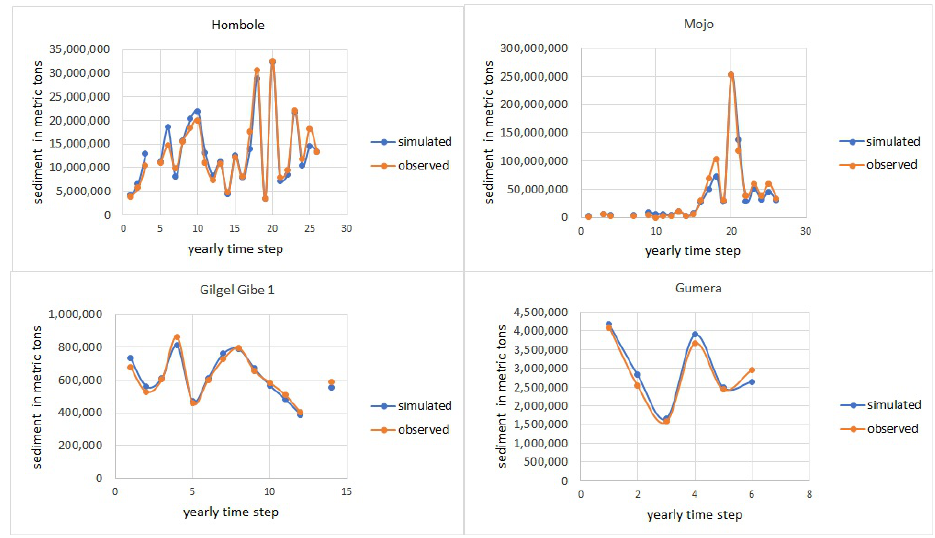
Figure 7. Observed and simulated sediment.